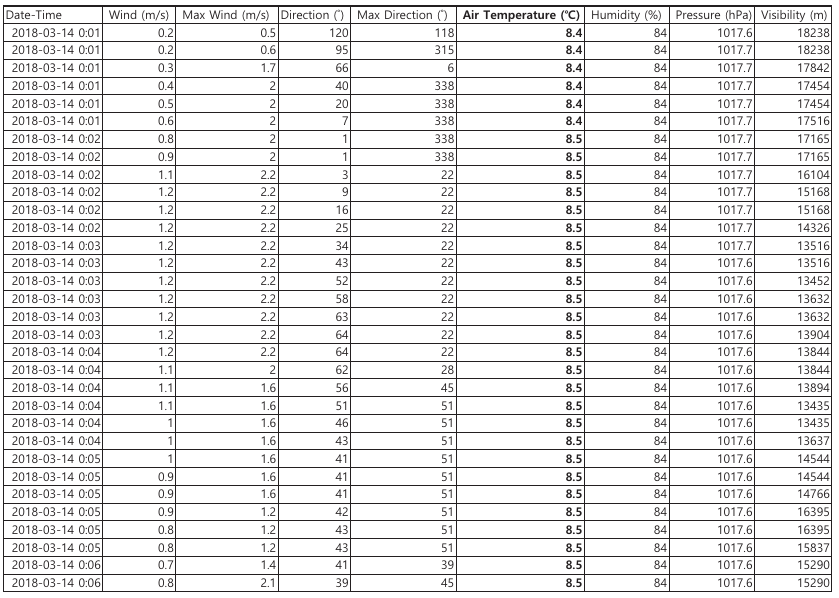
Figure 15. AWS information: date and time; wind speed, maximum wind speed, average wind direction, and maximum wind direction; air temperature, humidity, and pressure; and visibility.